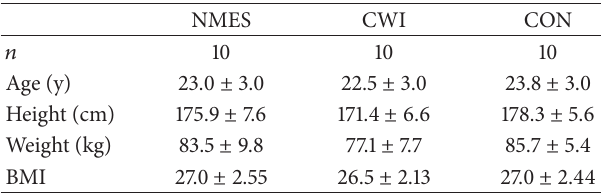
Table 1: Subject